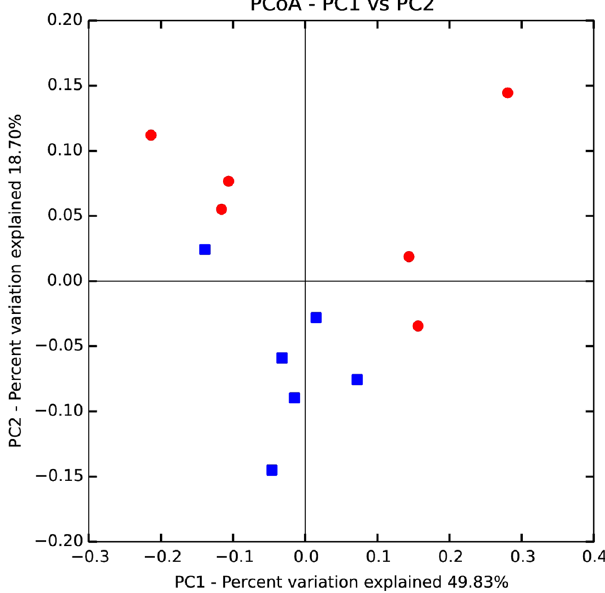
Figure 3. PCoA of microbial communities of sows fed the control diet (CON, N = 6) and the wheat bran- enriched diet (WB, N = 6) 98d (G98 + ) into gestation. Individual WB sows are displayed in red and CON sows in